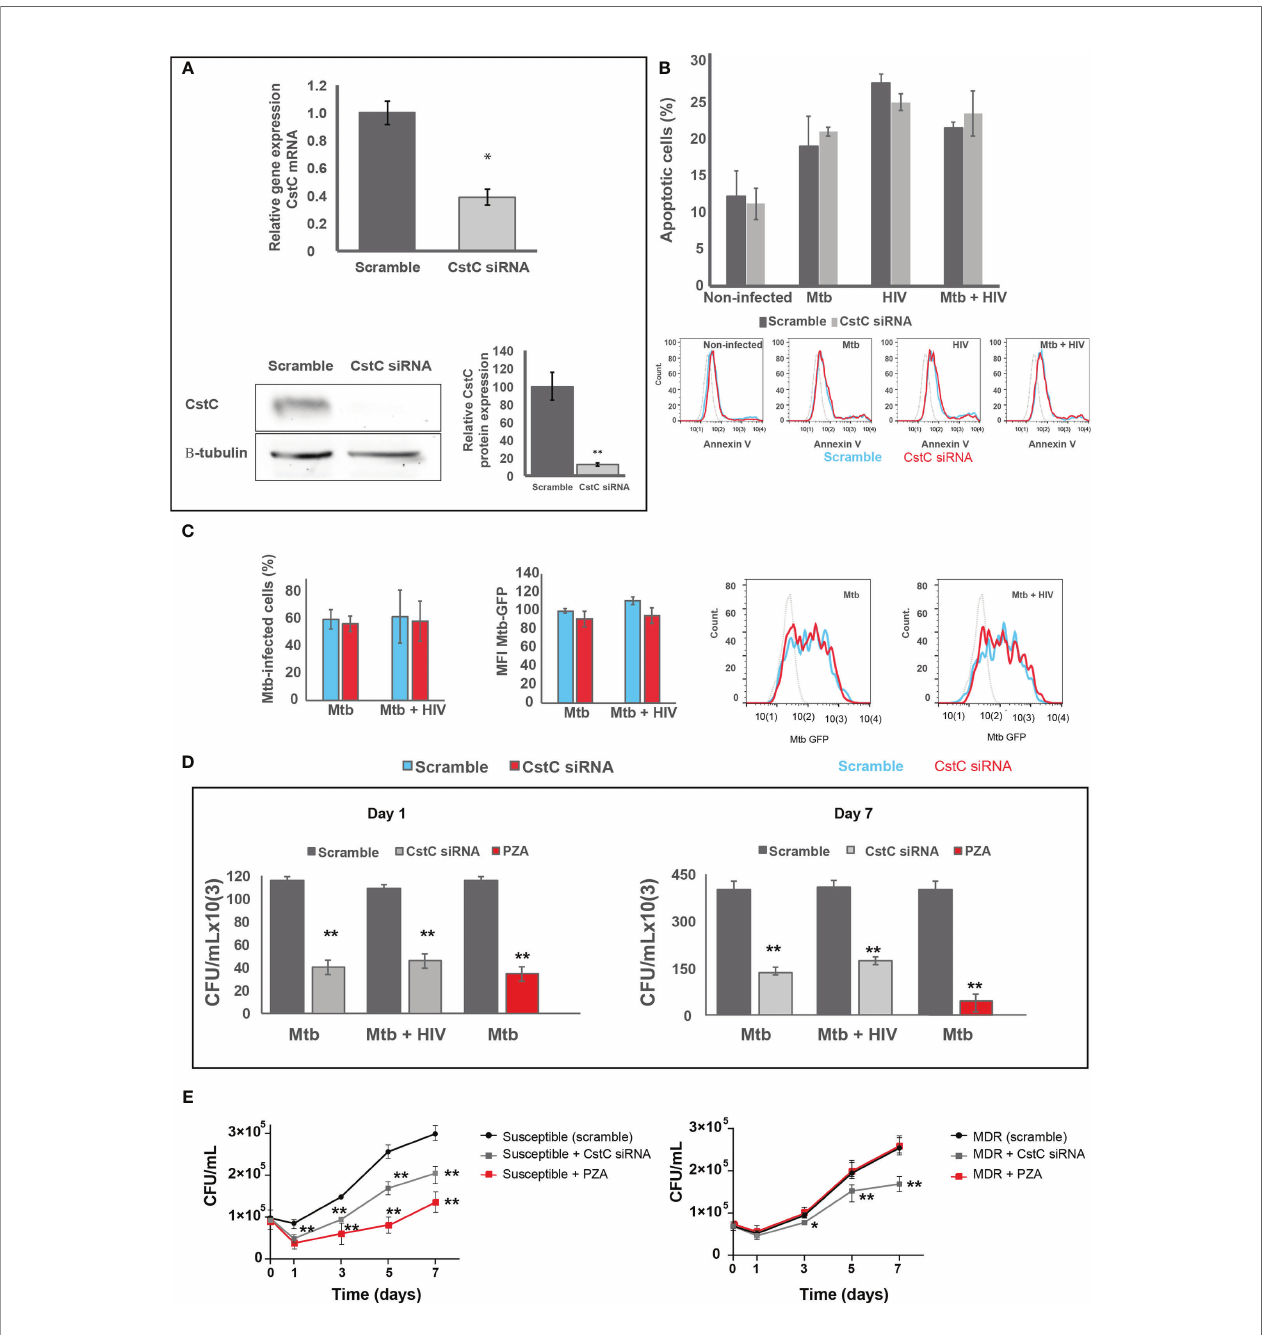
FIGURE 3 | SiRNA-mediated gene silencing for CstC results in increased Mtb killing in primary human Mø during mono-infection and during HIV coinfection. (A) CstC was silenced by siRNA 3 days prior to infection in order to achieve maximum protein silencing. Relative gene expression of CstC mRNA in Mø was determined by RT-qPCR and Western blotting at 24 h p.i. Values are relative to cells transfected with scramble and represent the average of biological triplicates (* p < 0.01; n = 3). (B) Effects of siRNA for CstC relative to scramble transfected cells on apoptosis in infected Mø. Apoptosis was measured by fl ow cytometry after 24 h of infection using fl uorescent annexin V antibodies. Values show median fl uorescence intensity (MFI) from one representative experiment performed in triplicate, while error bars depict the standard deviation. (C) Percentage of Mø infected with Mtb, and MFI of Mtb per Mø were measured by fl ow cytometry in scramble infected cells and in CstC-silenced infected cells, after 3 h of infection with a GFP-expressing Mtb strain. Bar plots depict the average of three biological replicates, and the error bars depict the standard error. Raw values from one representative replicate are presented in the fl uorescence intensity histograms. (D, E) Intracellular survival of Mtb: reference laboratory strain H37Rv (D) and clinical strains (E) . Colony-forming units (CFU) of intracellular bacteria were recovered from Mø transfected with siRNA for CstC or with a scramble siRNA. Values depict mean CFU representative of three biological replicates measured in duplicate, while the error bars depict the SD. Asterisks indicate statistical signi fi cance between samples at the same time point relative to scramble control (* p < 0.01; ** p < 0.001; n = 3). PZA was used as control for killing ef fi cacy. Mtb, Mycobacterium tuberculosis ; Mø, macrophages; PZA,